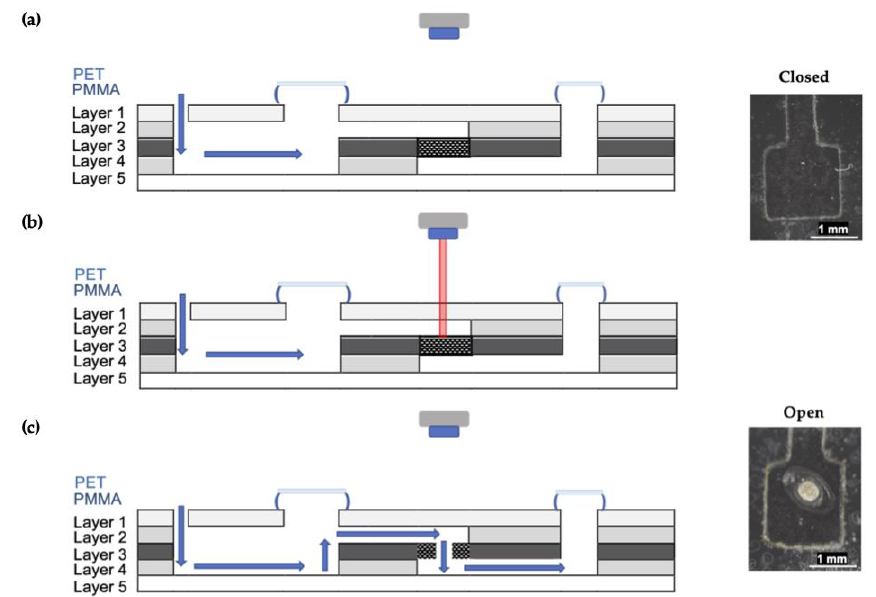
Figure 5. Schematic depicting a lateral view of microdevice architecture. ( a ) Reagents are introduced to the device via the inlet and held in the upper chamber by a closed laser valve. Mixing occurs via rapid rotations using the spin system. ( b ) The toner patch absorbs energy, and the PET layer is melted. ( c ) The solution can then be transferred from the first chamber to the second via the open laser valve.